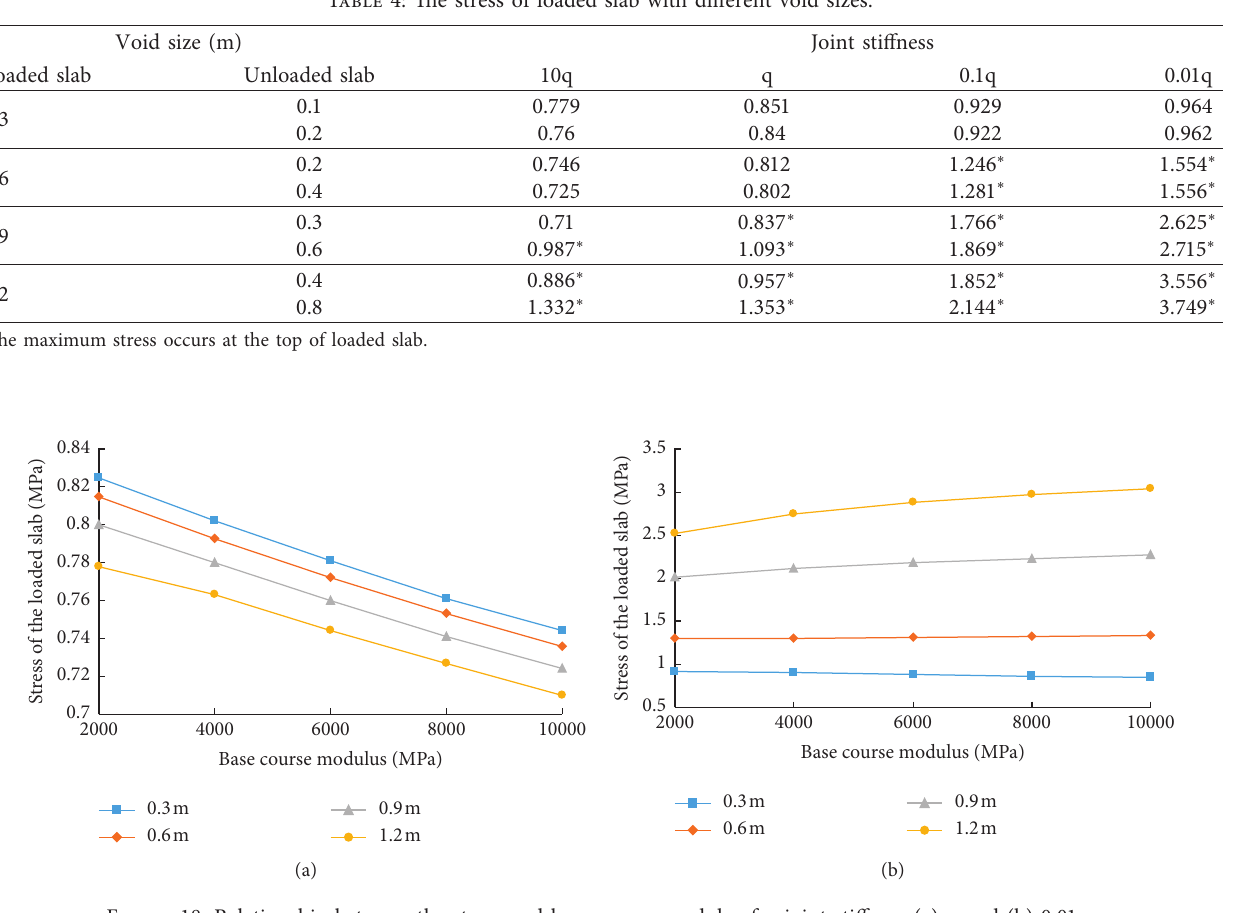
Figure 18: Relationship between the stress and base course modulus for joint stiffness (a) q and (b) 0.01q.